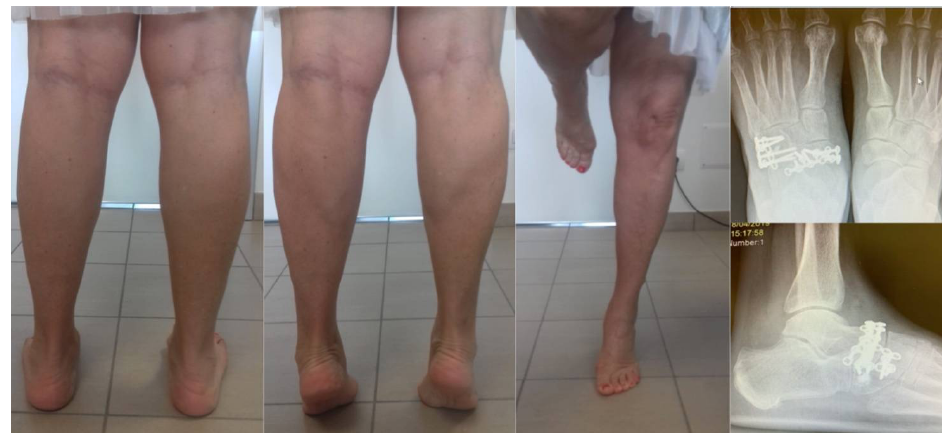
Figure 6. Twenty-four-month follow-up.